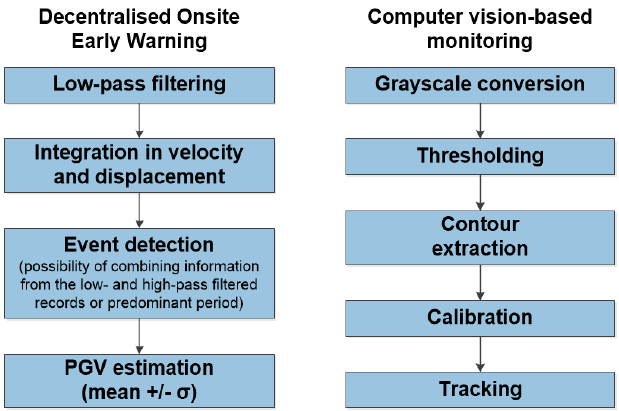
Figure 3. The steps followed when the MPwise units are being employed for ( a ) decentralized on-site earthquake early warning [5] and ( b ) computer vision-based monitoring roles. Note the GFZ-Sentry application would be employed for the decentralized on-site early warning.